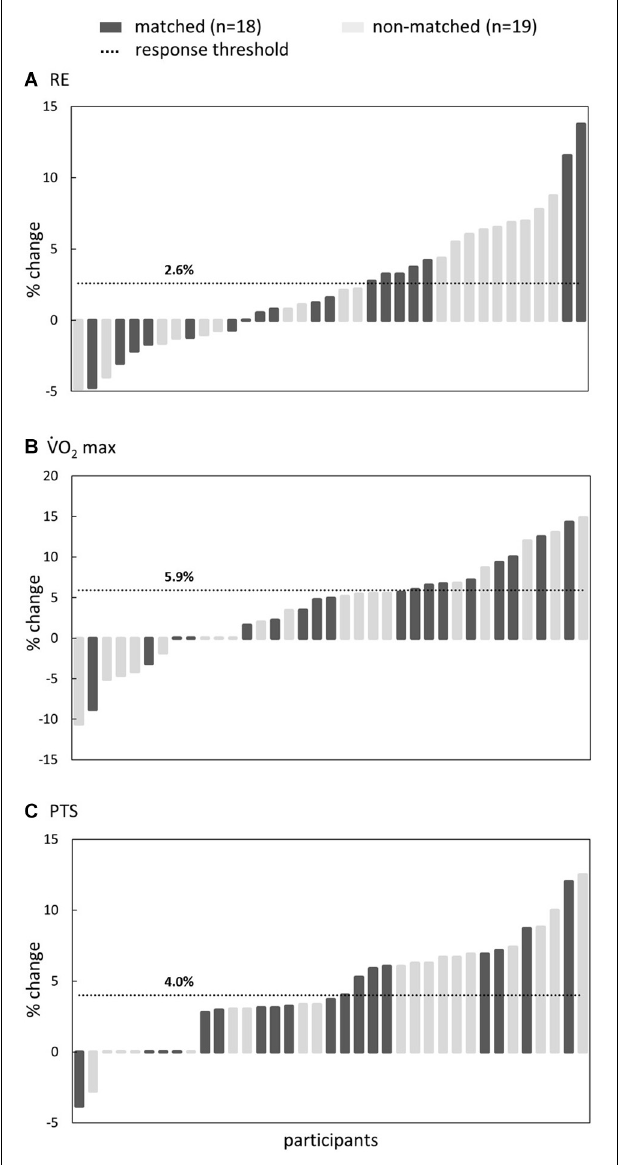
FIGURE 2 | Individual response (in % change) for (A) running economy (RE), (B) maximal oxygen uptake ( ˙ VO 2 max), and (C) peak treadmill speed (PTS). Dark gray and light gray bars indicate the matched and non-matched groups, respectively. The horizontal line represents the threshold for identification of a participant as a (non-)responder. Participants are ranked for each variable from least (left) to most (right) desired